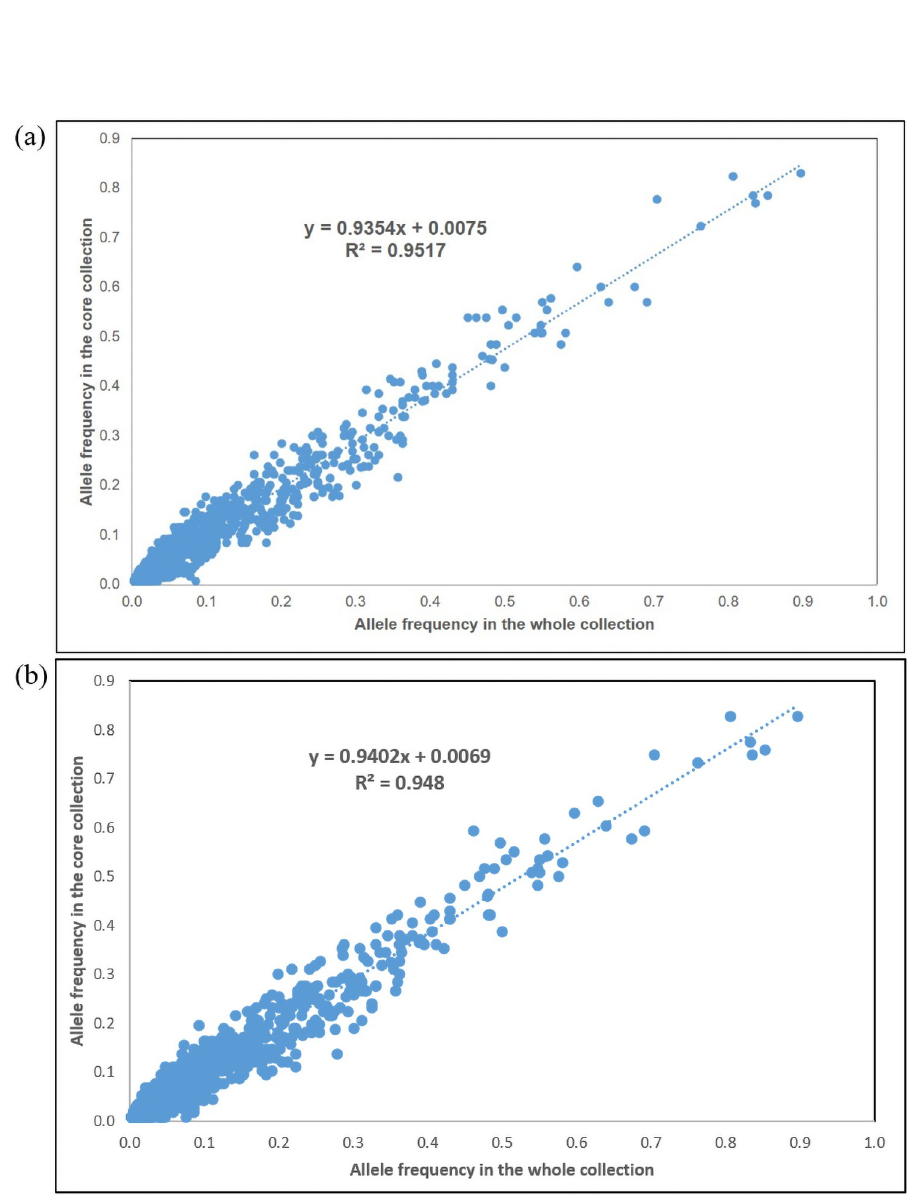
Fig 4. Correlation between allele frequency of the 928 SSR alleles in the core sets and in the whole collection (186 palms). (a) Core set developed using PowerCore (65 palms); (b) Core set developed using Core Hunter (58 palms).